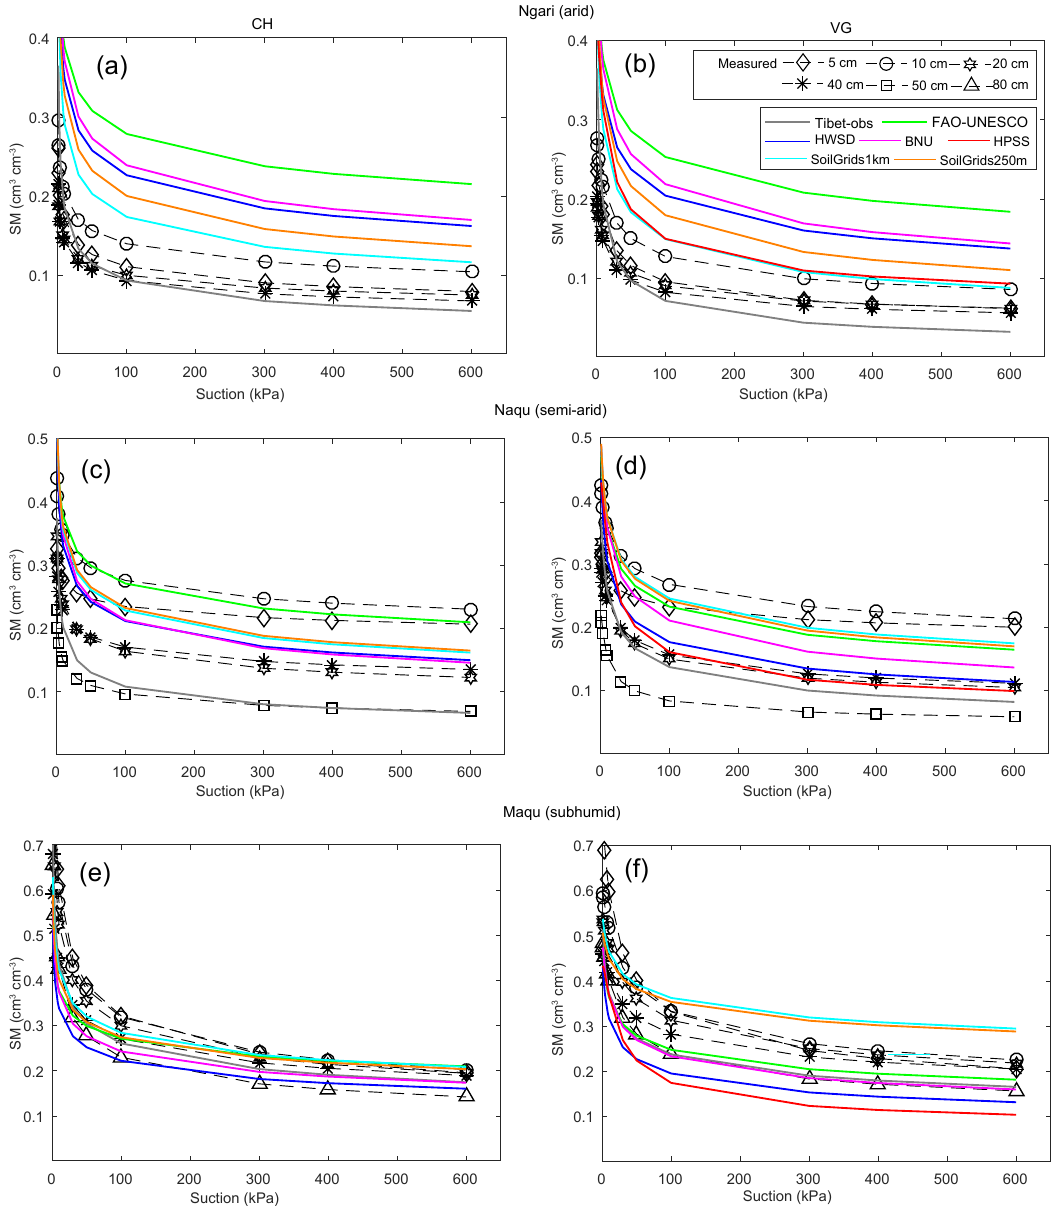
Figure 13. Comparisons of SWRCs, derived from the applicable PTFs based on various datasets, with laboratory measurements. (a) , (c) and (e) represent the SWRCs by the CH model based on six datasets. (b) , (d) and (f) represent the SWRCs by the VG model based on seven datasets, in which HPSS only provides hydraulic parameters for the VG